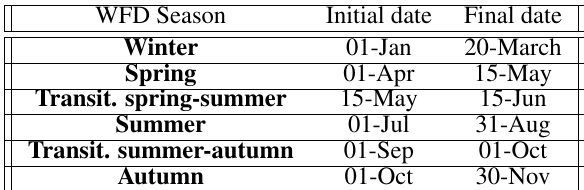
Table 2. Water Framework Directive seasons’ initial and final dates. (Bresciani et al.,